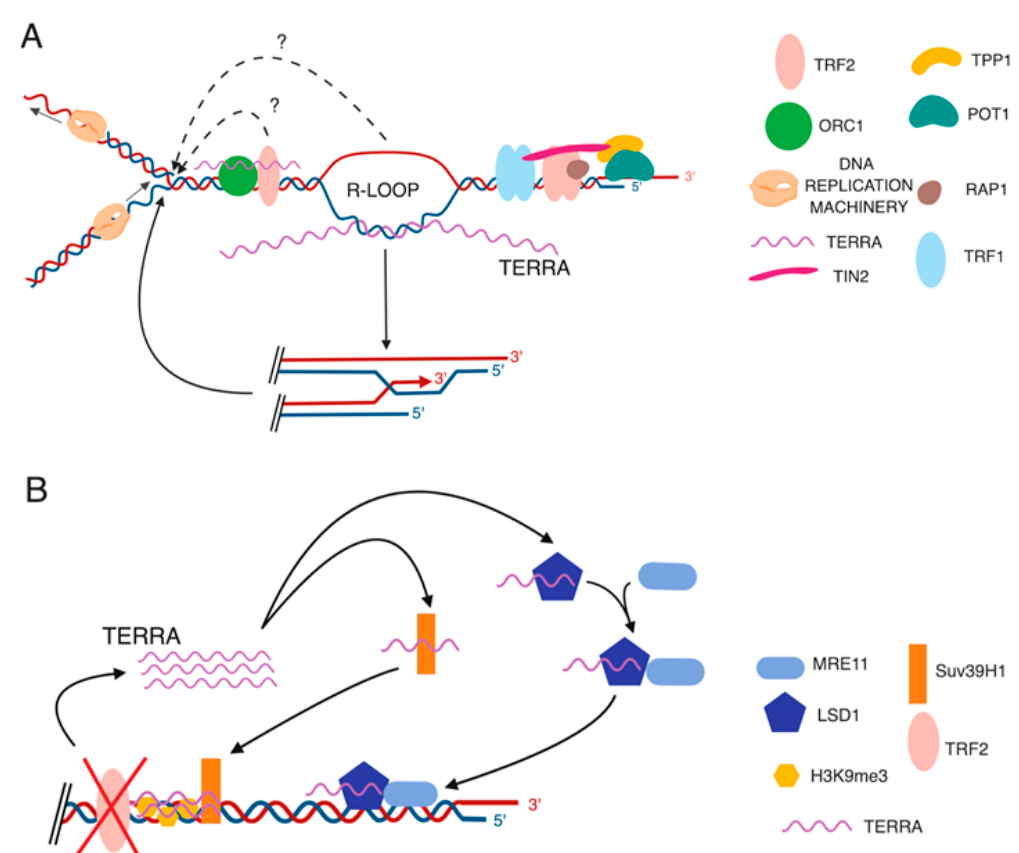
Figure 2. Proposed TERRA functions in telomere maintenance. ( A ) TERRA transcripts may facilitate DNA replication at telomeres by promoting the recruitment of the origin replication complex 1 (ORC1) at chromosome ends or through the formation of DNA ‒ RNA hybrids (R-loops) at chromosome ends. Telomeric R-loops promote homologous recombination among telomeres, which protects replication forks from collapsing and becoming dysfunctional during replication stress. ( B ) TERRA sustains DNA damage response at dysfunctional telomeres. Depletion of TRF2 results in increased TERRA levels. TERRA transcripts promote the recruitment of LSD1 ‒ Mre11 complex at chromosome ends, which can fuel DNA damage response at dysfunctional telomeres. TERRA also interacts with Suv39h1 histone methyltransferase. In TRF2-depleted cells, TERRA ‒ Suv39h1 interaction promotes H3K9me3 accumulation at dysfunctional telomeres, sustaining the DNA damage